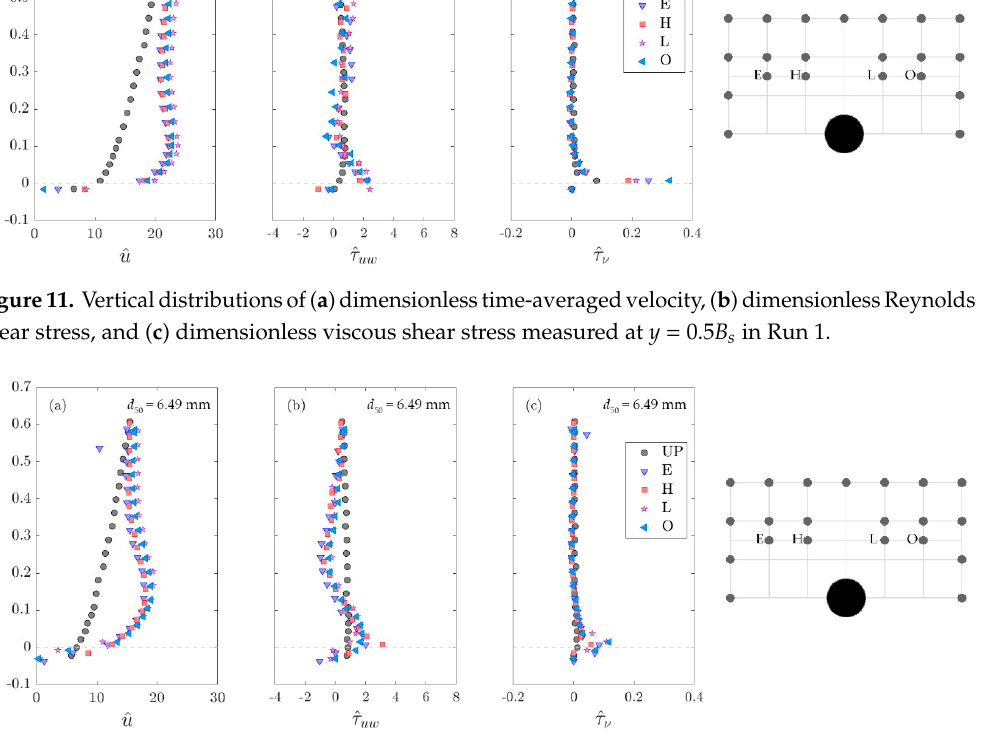
Figure 12. Vertical distributions of ( a ) dimensionless time-averaged velocity, ( b ) dimensionless Reynolds shear stress, and ( c ) dimensionless viscous shear stress measured at y = 0.5 B s in Run 2.